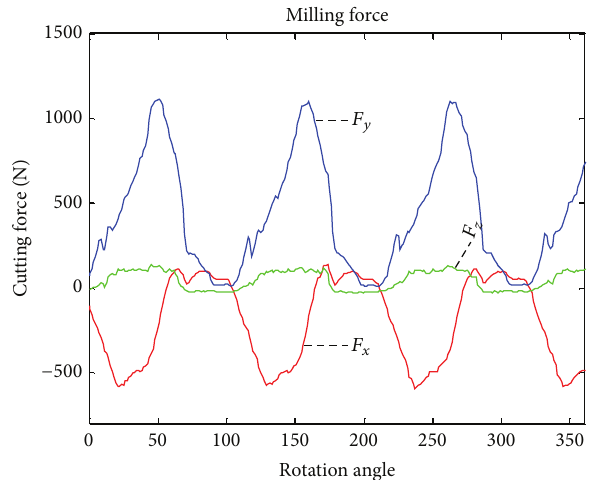
Figure 7: Cutting force in x / y / z direction (cutting speed 125m/min, cutting depth 8 mm, and the feed